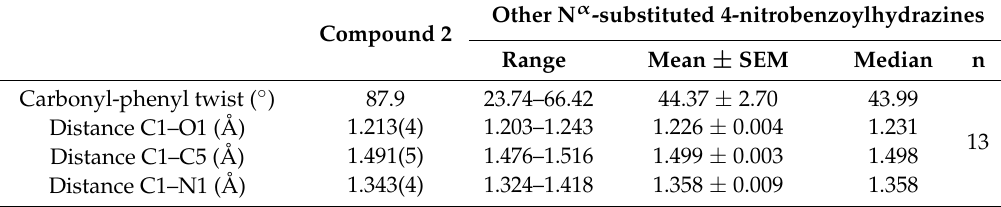
Table 2. Solid-state structural parameters for the amide moieties of Compound 2 and related N α -substituted 4-nitrobenzoylhydrazines *.